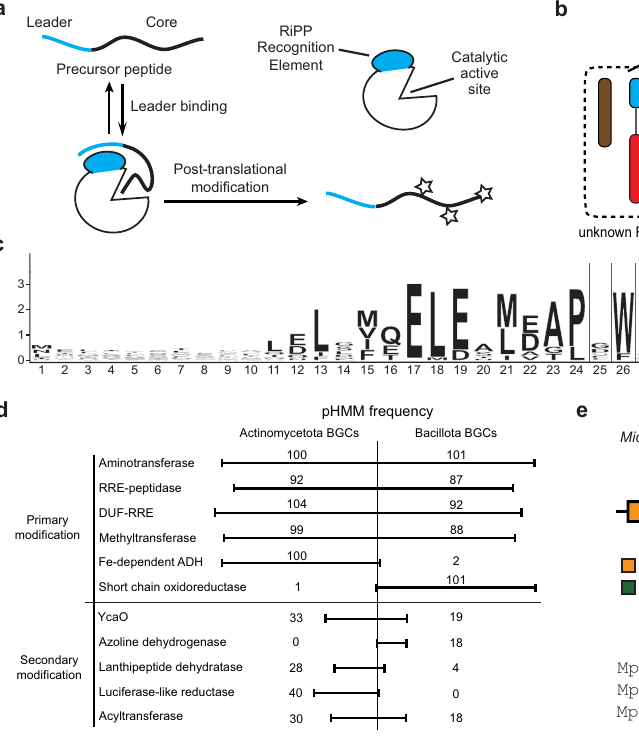
PF13649,PF08241,PF13849,PF08242;Fe-dependentalcoholdehydrogenase(ADH) – PF00465, TIGR03405, PF13685; Short chain oxidoreductase – PF13561, TIGR01830, TIGR02638; YcaO – PF02624, TIGR01575; Azoline dehydrogenase – TIGR03605; Lanthipeptide dehydratase – PF00069, TIGR03897; Luciferase-like reductase – TIGR03564, PF00296; Acyltransferase – PF00583, TIGR01575. e Targeted BGC from Microbacterium paraoxydans DSM 15019 identi fi ed from the genome mining analysis of